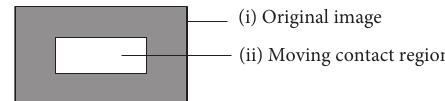
Figure 4: Moving contact area. The white area is the moving contact area. (i) The original image. (ii) The moving contact